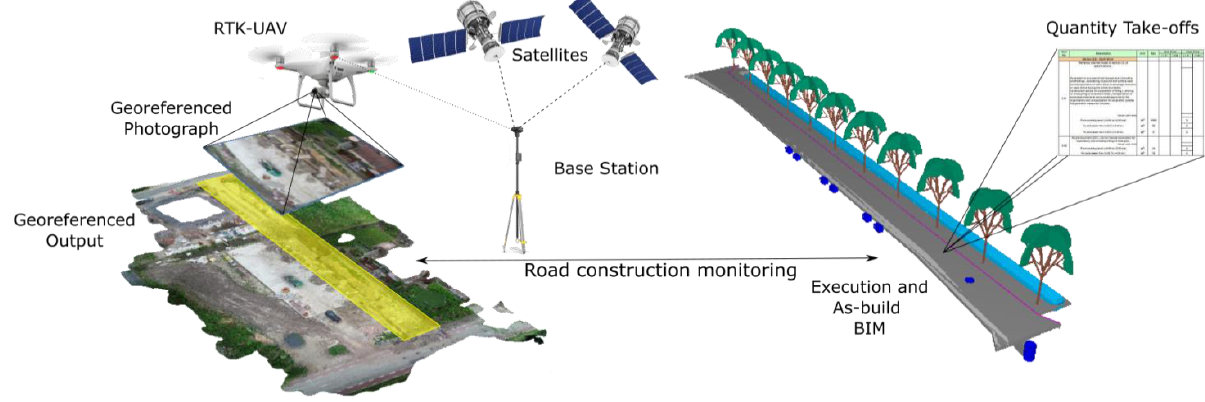
Figure 1. Schematic overview of the research (left)to automate the RTK-flight processing and (right) automated quantity take-offs from the As-built BIM